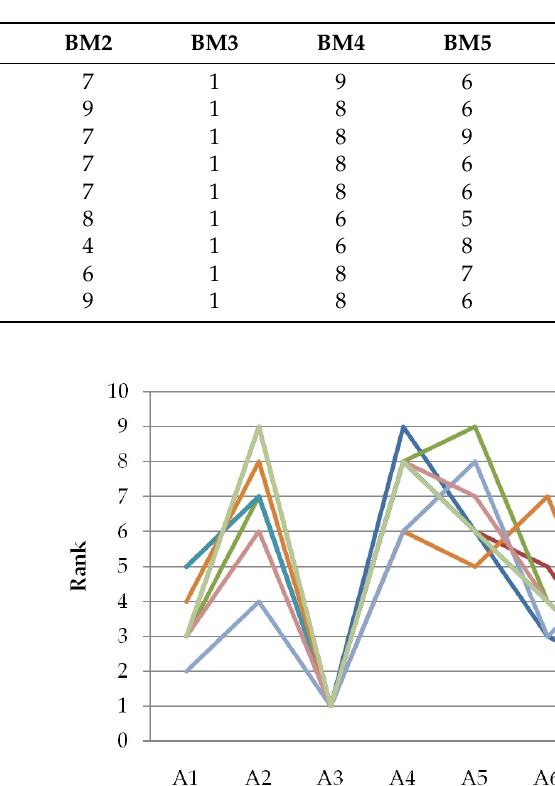
Table 8. Ranking comparison by various MCDM methods.